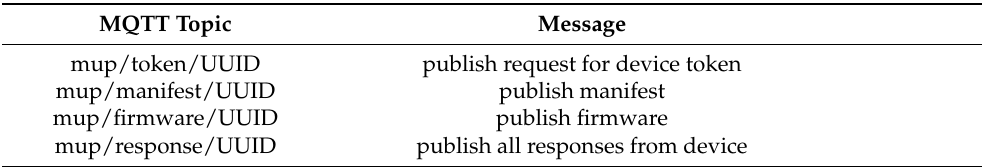
Table 3. MQTT topics for